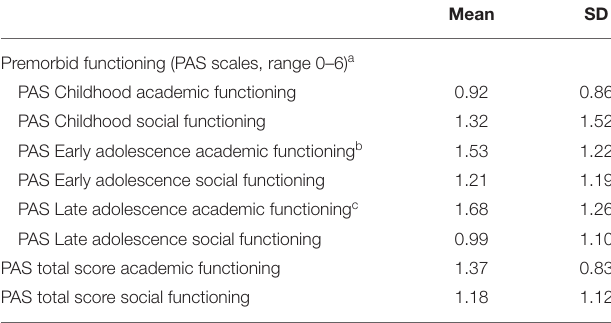
TABLE 2 | Premorbid functioning as measured by the